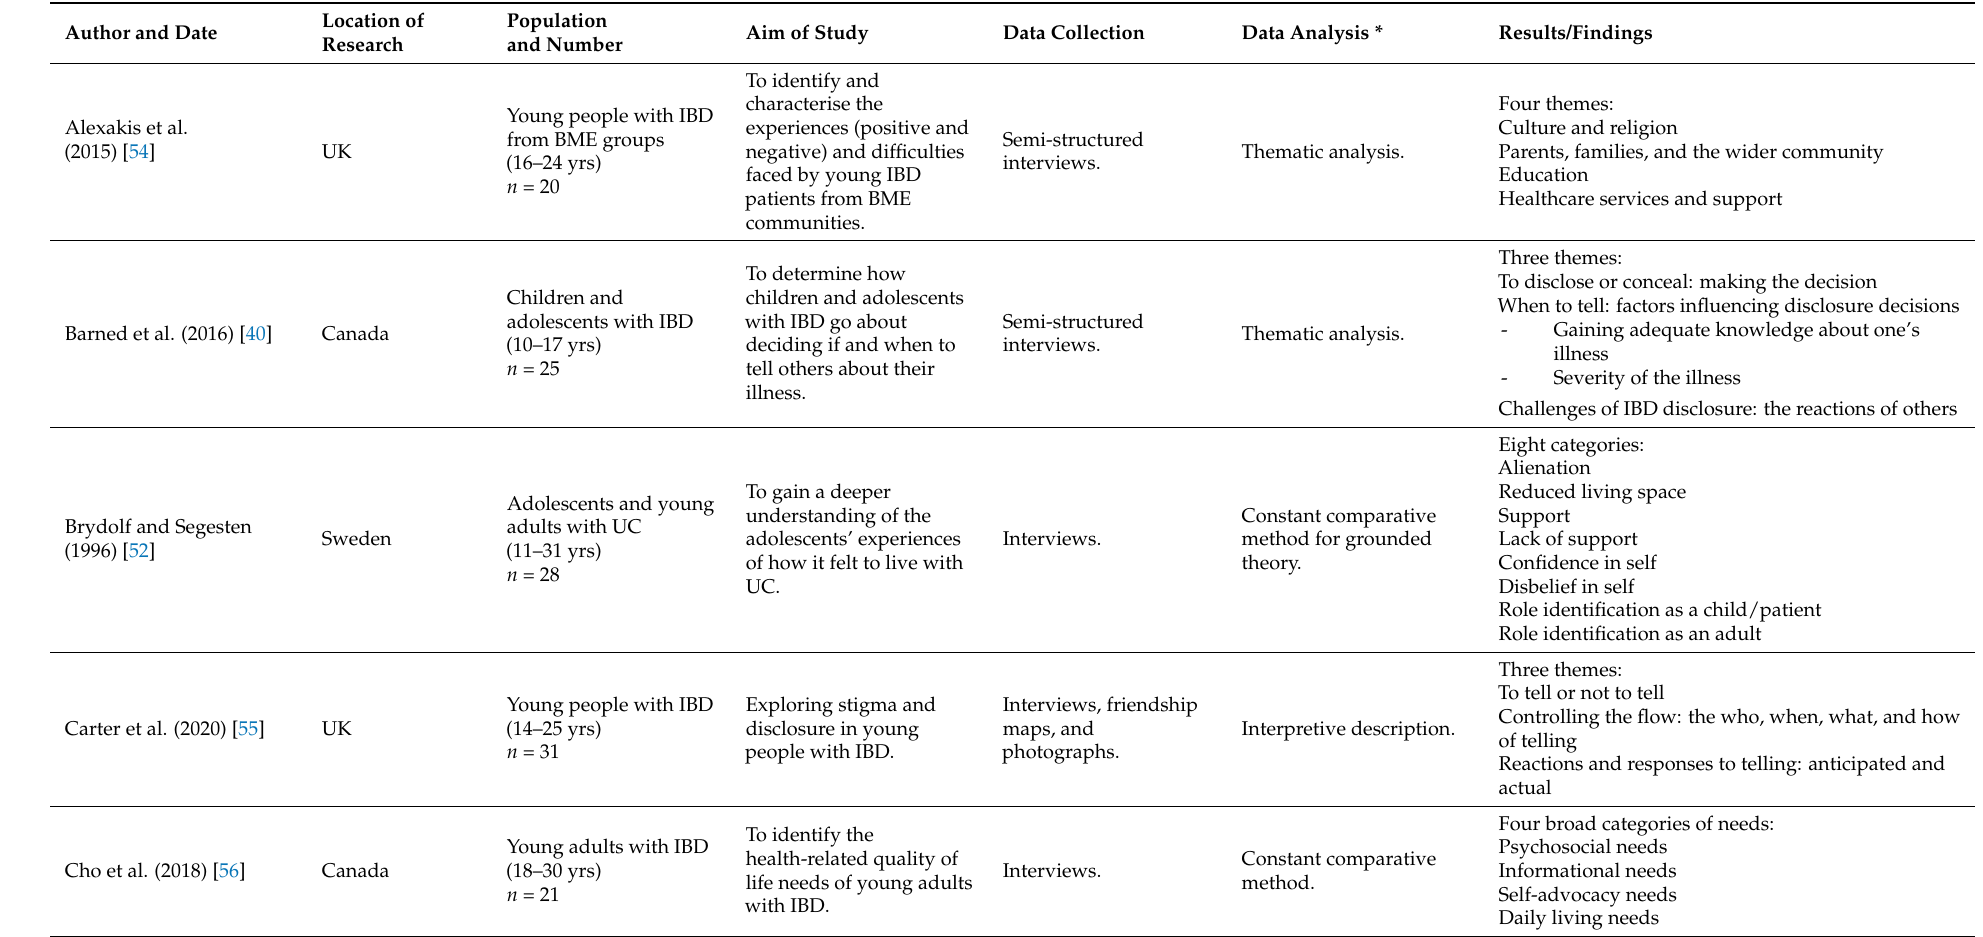
Table 2. Attributes of included